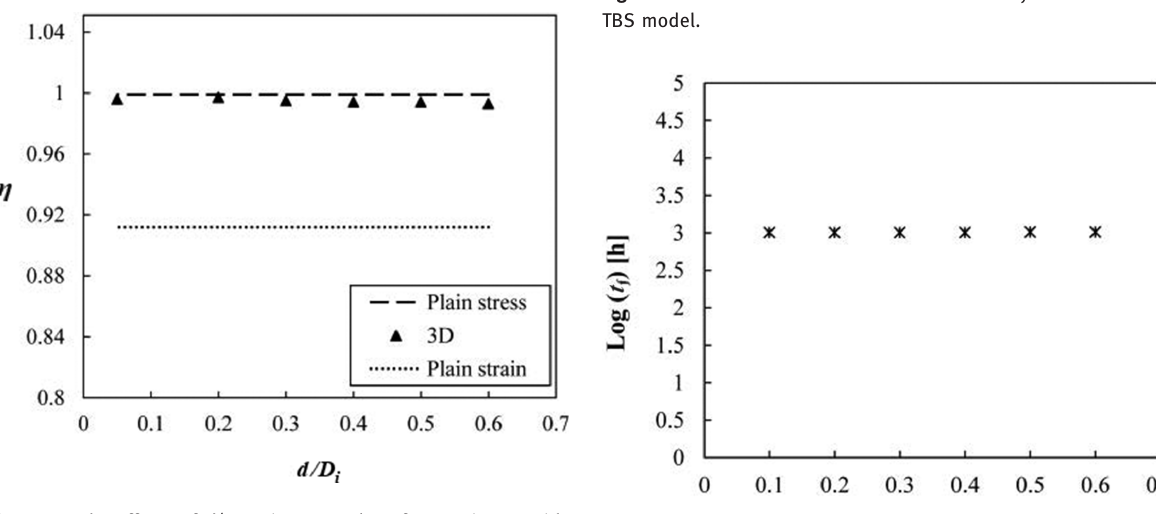
Figure 10: The effects of d / D i ratio on η values for specimens with L